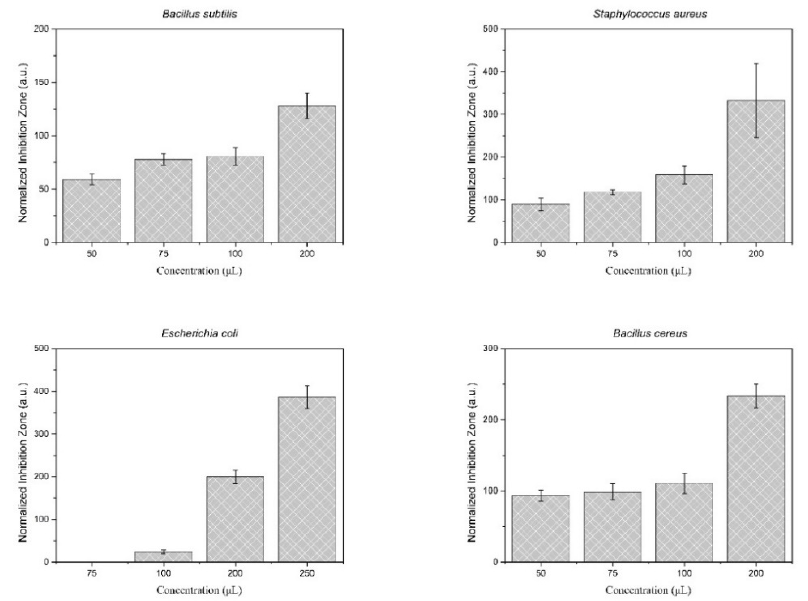
Figure 12. Antimicrobial activity assessment of the synthesized nanoparticles, against four microorganisms of interest. The test was performed in the presence of 50, 75, 100, 200, and 250 µ L of 10% w/v nanoparticle suspension in ddH 2 O (total D-limonene content: 0.51, 0.76, 1.01, 2.02, and 2,53 µ g, respectively, as-determined by TGA analysis).